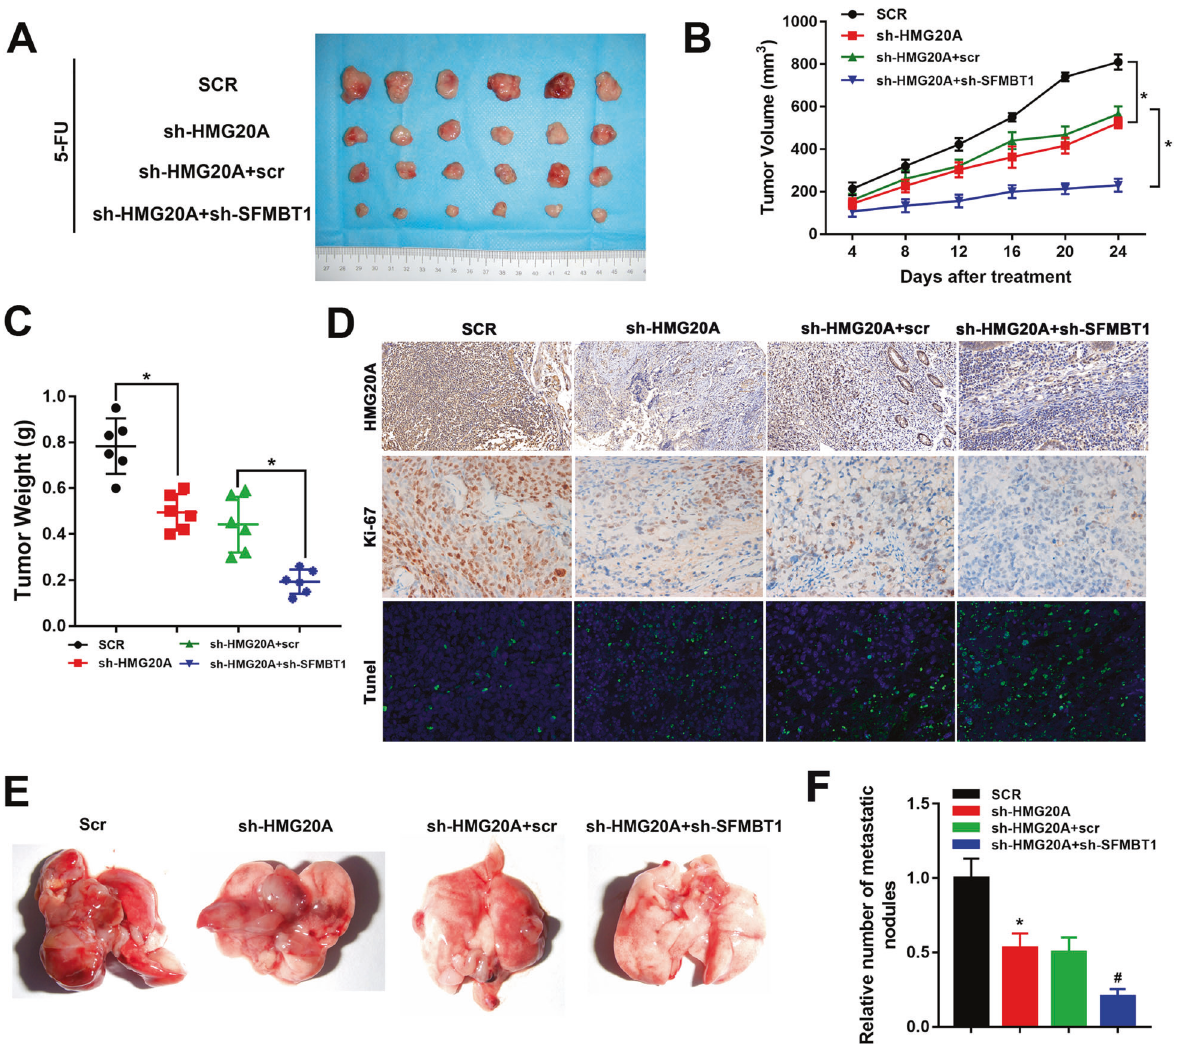
Fig. 7 SFMBT1 in combination with HMG20A promotes the proliferation and metastasis of CRC in vivo. A Xenografts derived from nude mice subcutaneously injected with the indicated cells ( n = 6). B Tumor volume after different treatments. C Tumor weight of nude mice recorded every 4 days after the initial treatment. D Immunohistochemistry staining of HMG20A and Ki67 and TUNEL staining of tumor tissues. Scale bars = 100 μ m. E Representative images of lungs from each group of metastatic tissue sections. F The relative number of metastatic nodules were quanti fi ed. * P < 0.05, # P <